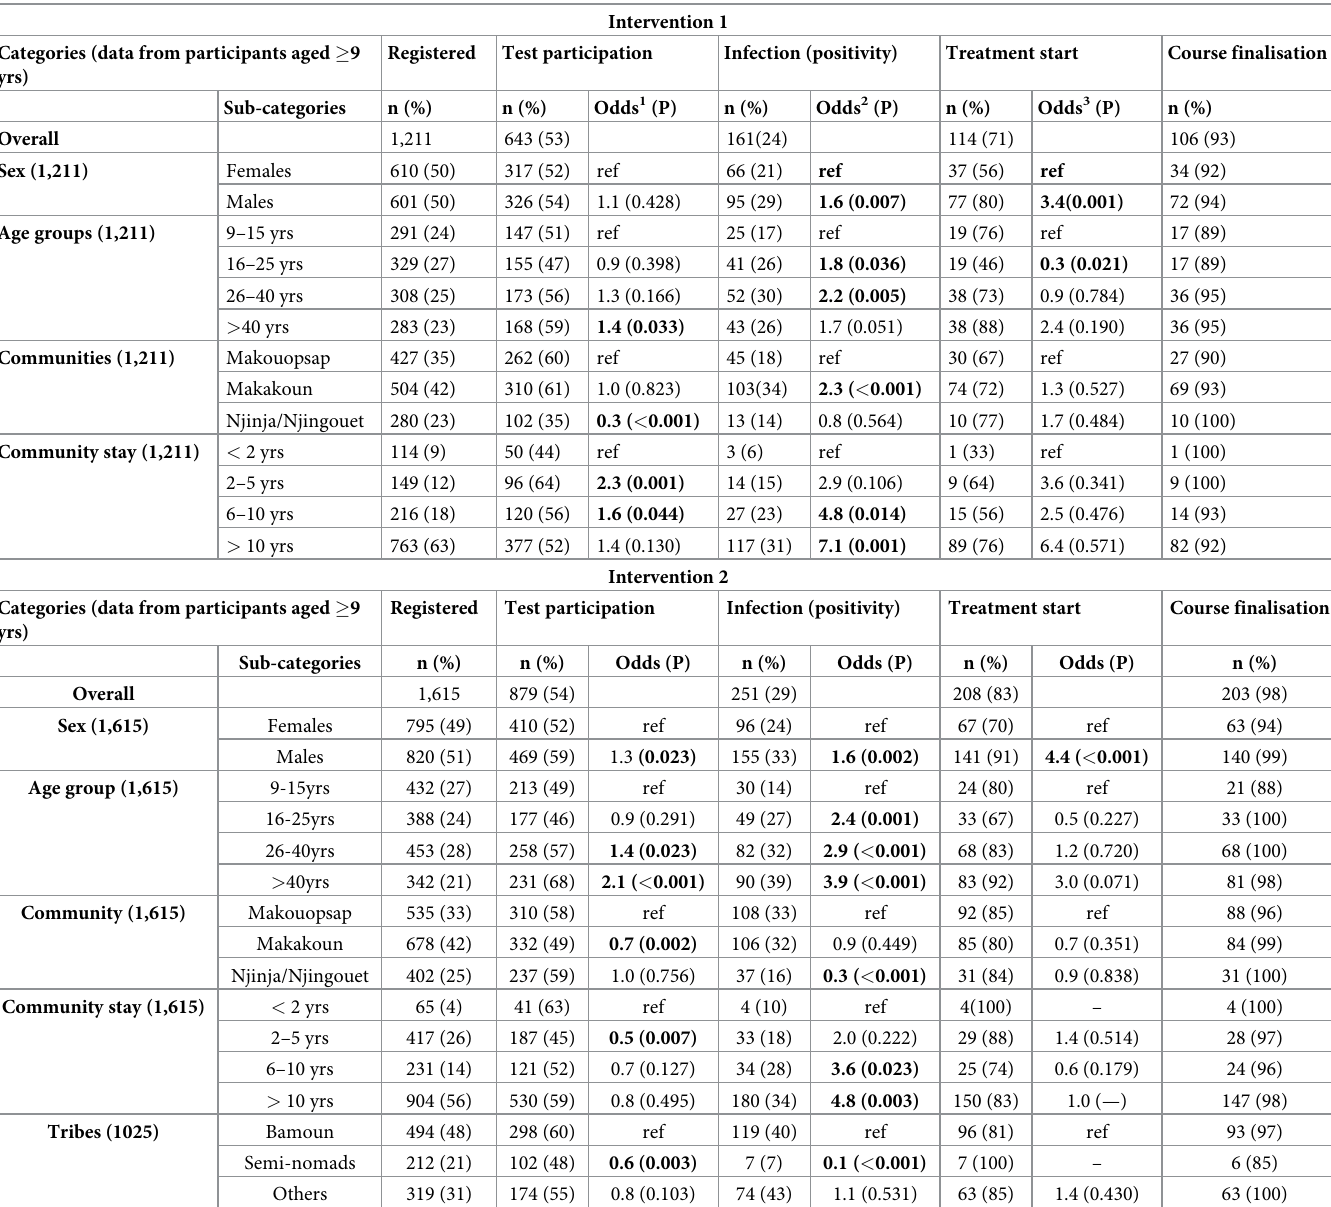
Table 2. Intervention 1 and 2 screen and treatment participation